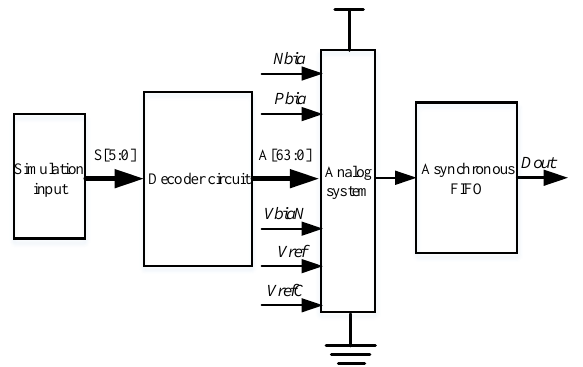
Figure 9. Schematic of digital-analog mixed post-simulation.